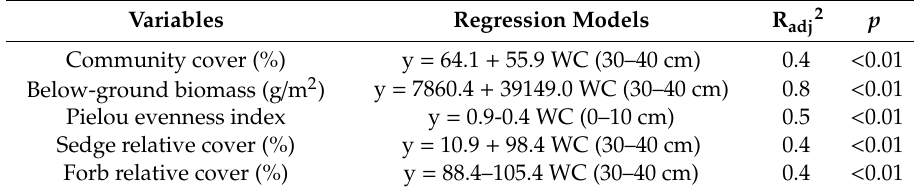
Table 6. Step-wise multiple linear regressions of soil water content from di ff erent depths (0–10